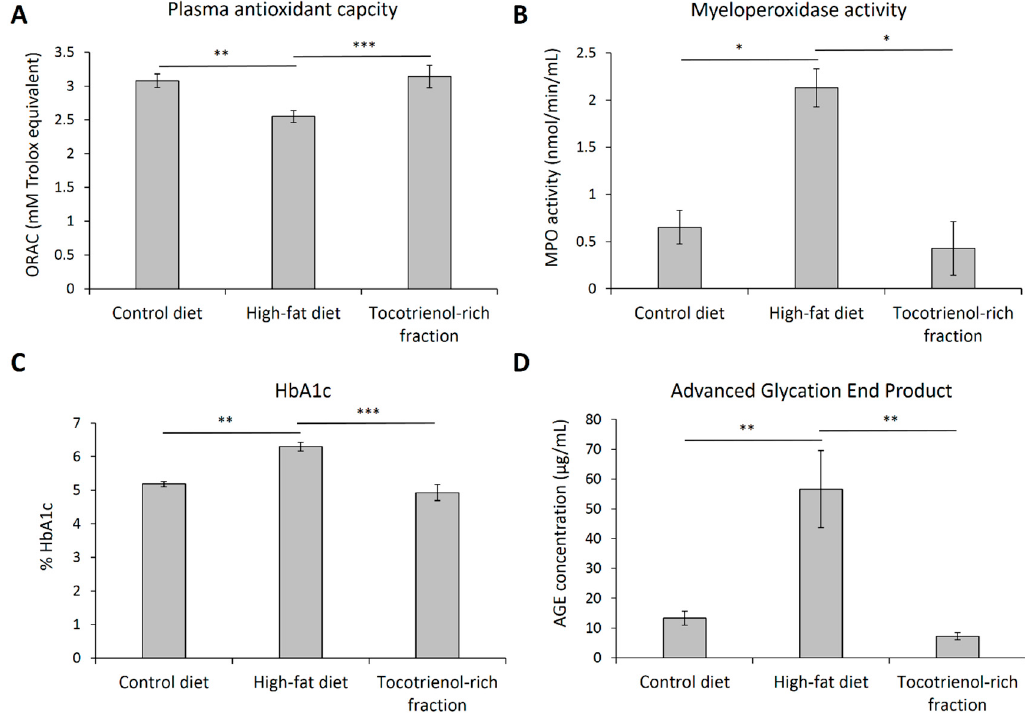
Figure 5. Total plasma antioxidant capacity ( A ), myeloperoxidase activity ( B ), glycated hemoglobin A1c ( C ), and advanced glycation end product ( D ) of the rats assigned to different treatment groups at the end of treatment. Error bars indicate SEM. The sample size was n = 7 per group. * Indicates p < 0.05, ** Indicates p < 0.01, and *** Indicates p < 0.001 between groups. AGE: advanced glycation end product; HbA1c: glycated hemoglobin A1c; MPO: myeloperoxidase; ORAC: oxygen radical absorbance capacity.